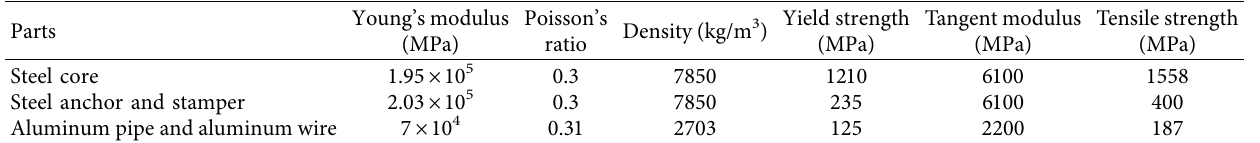
Figure 3: Schematic diagram of the geometric construction of an NY-300/40 strain clamp: (a) cross section of the steel core and aluminum strands; (b) aluminum pipe; (c) steel anchor. Table 1: Mechanical properties of the strain clamp and conductor